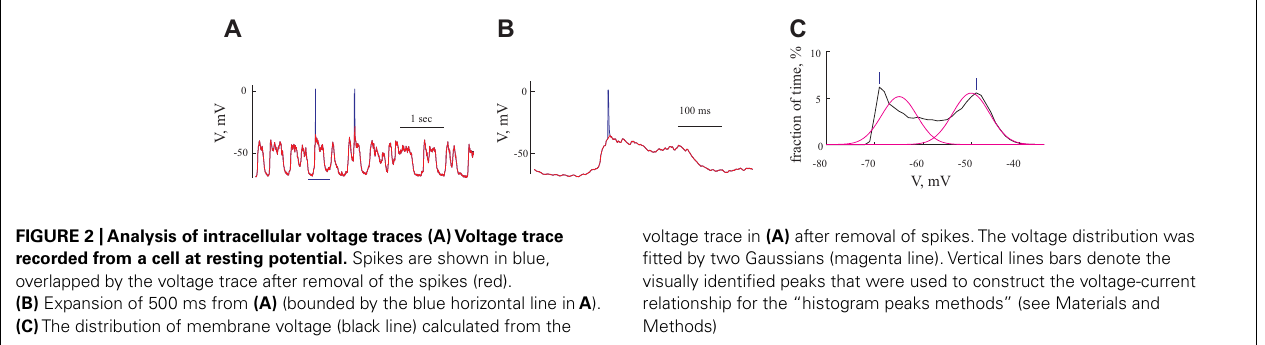
voltage trace in (A) after removal of spikes.The voltage distribution was fitted by two Gaussians (magenta line).Vertical lines bars denote the visually identified peaks that were used to construct the voltage-current relationship for the “histogram peaks methods” (see Materials and